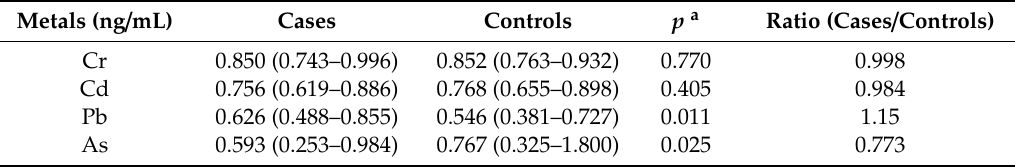
Table 2. Serum concentrations of THMs in schizophrenic patients (cases) and healthy subjects (controls). Metals (ng /